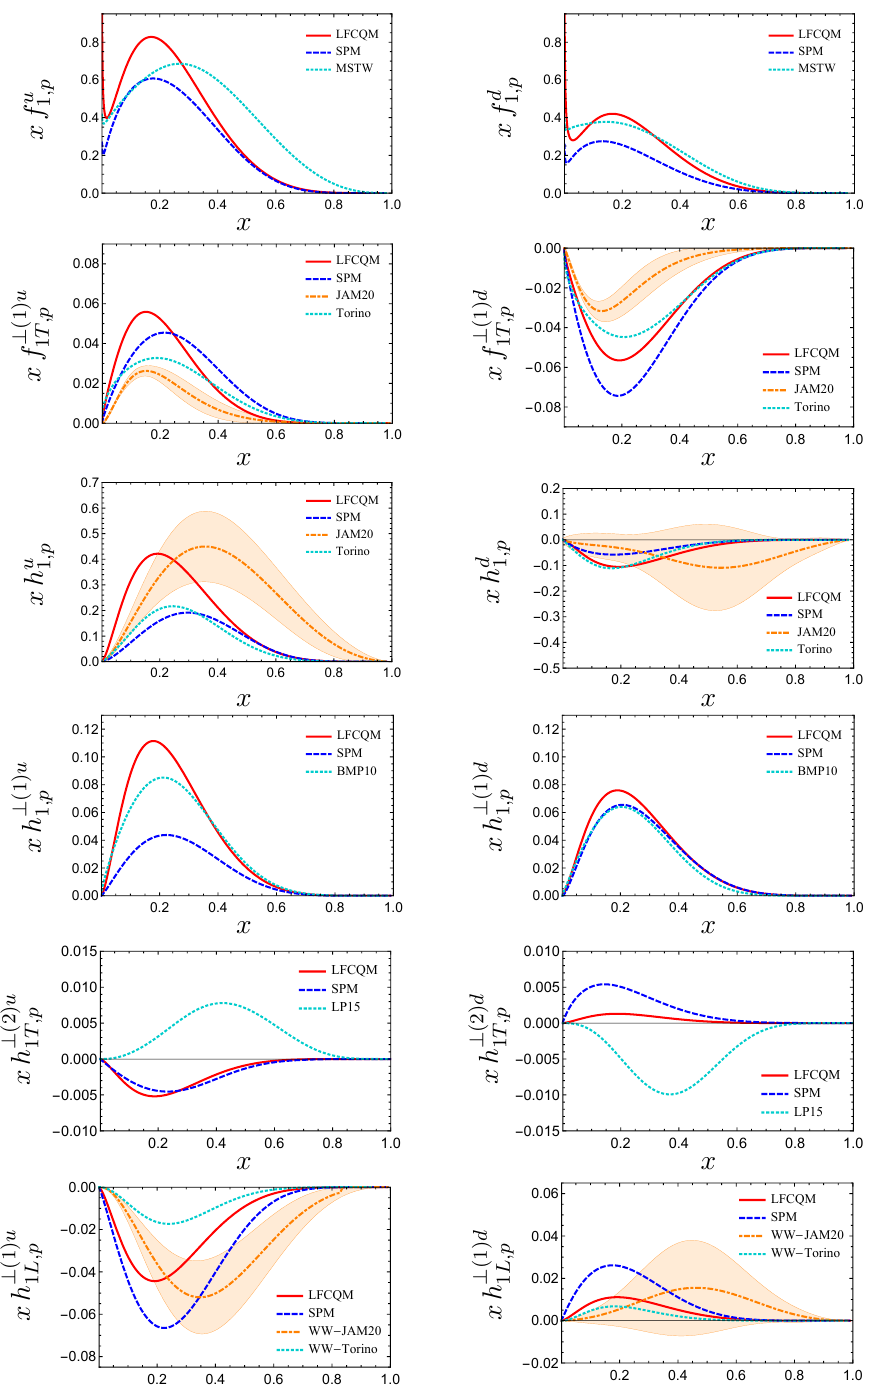
Figure 4 . The proton TMDs of u and d quarks in LFCQM [54, 57, 58] and SPM [50] at the scale Q 0 compared to phenomenological (cid:12)ts for f 1 ;p from MSTW2008(LO) [26], f ? (1) a Torino [34], h a from JAM20 [38] and Torino [35], h ? (1) a 1 ;p Sivers and Boer-Mulders TMDs are shown with the sign for DY process. The error bands show the 1- (cid:27) uncertainty of the JAM20 extractions